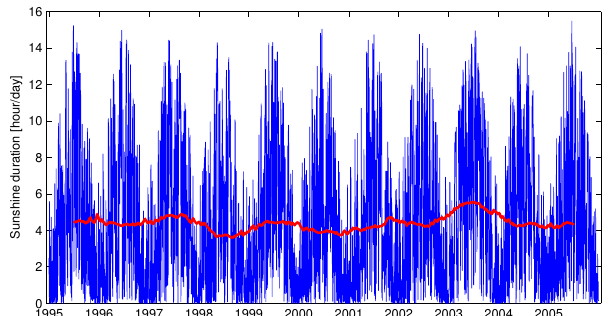
Figure 5. Time series of the daily sunshine duration spatially av- eraged over Belgium and Luxembourg (blue curve) and the corre- sponding one-year moving window average (red